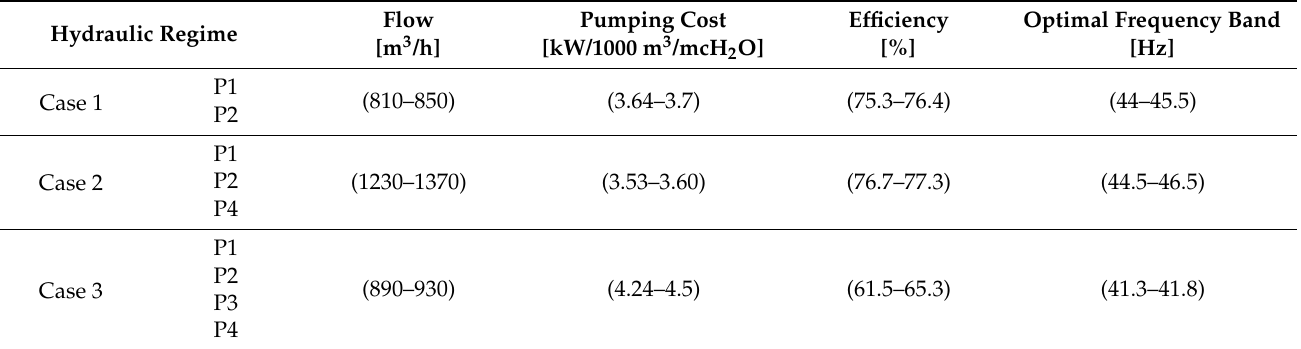
Table 4. The decision matrix for each hydraulic operating